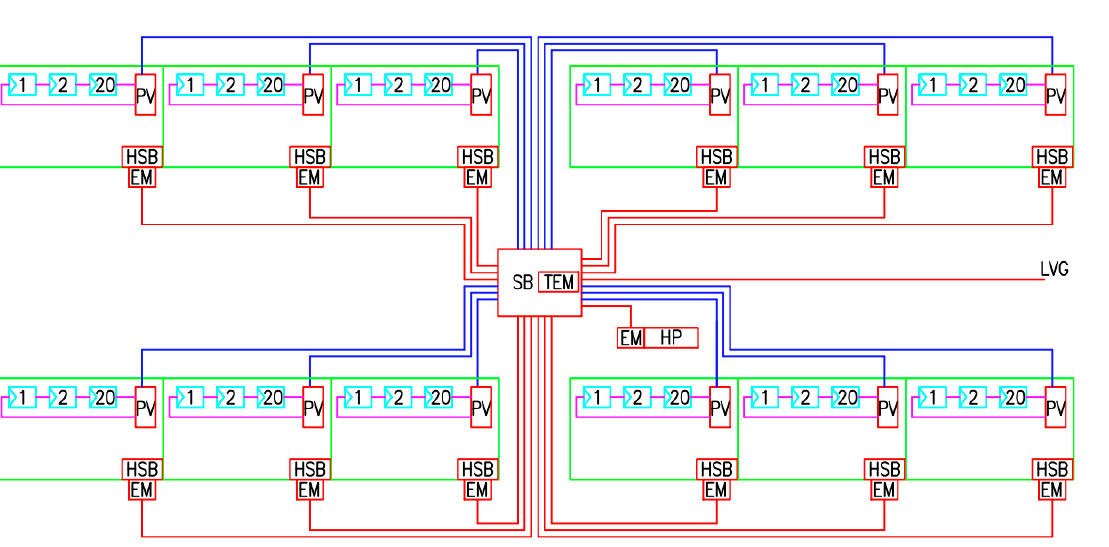
Figure 9. A block diagram of the electrical system in the considered housing estate. PV—disconnector DC, inverter, energy produced meter. HP—heat pump. SB—main switchboard (400/230 V). HSB—house switchboard. EM—energy meter. TEM—two-way energy meter. LVG—low voltage grid. 1, 2, … 20—PV modules in a string.